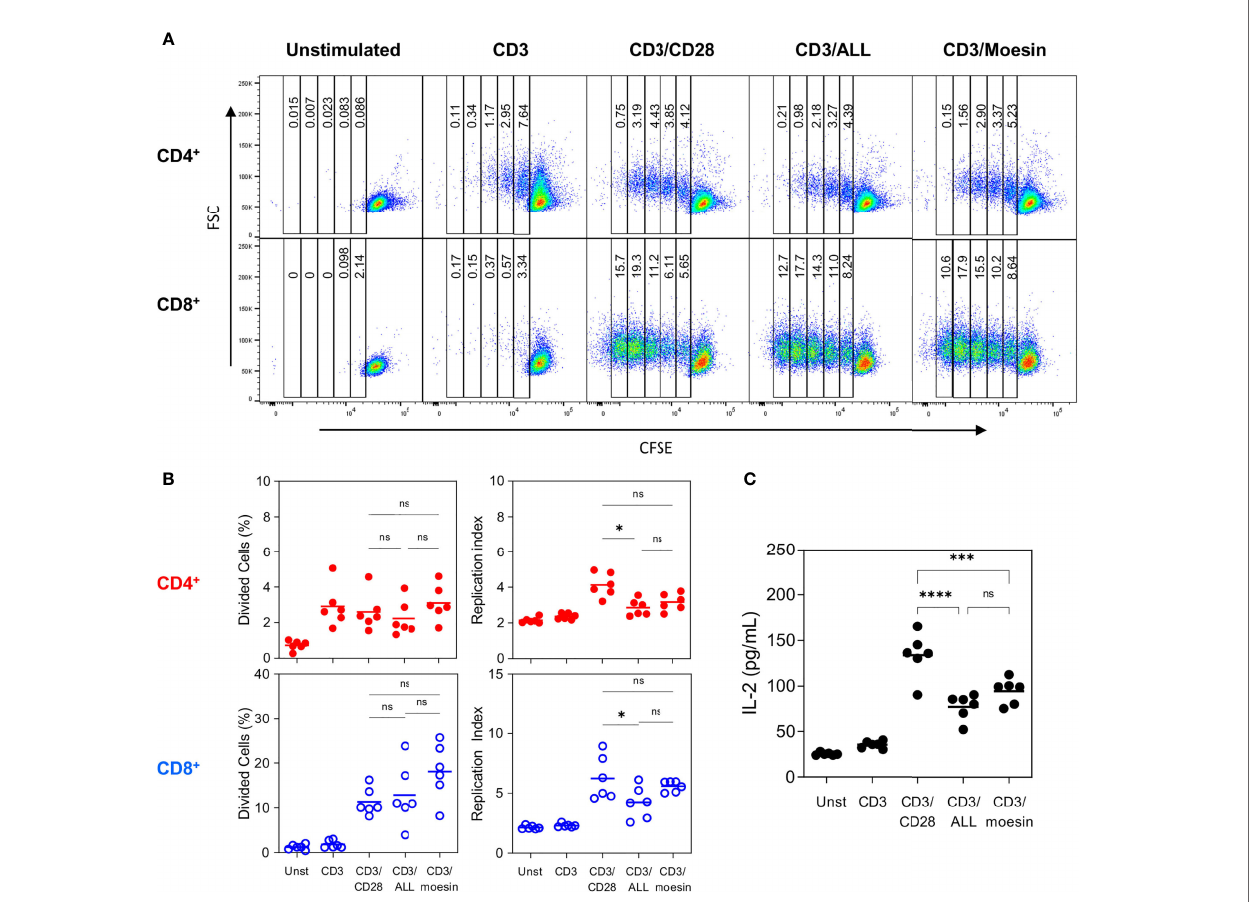
FIGURE 6 | Moesin costimulation induces proliferation in CD4 + and CD8 + T lymphocytes. Samples described in Figure 6 were further and identically analyzed within the CD4 - CD8 + and CD4 + CD8 + subsets to evaluate CFSE dilution. (A) Representative proliferation pattern analysis of CD4 + and CD8 + cells after activation with anti-CD3 and each costimulatory molecule. (B) Statistical analysis from 2 independent experiments with 3 mice per group expressed as the percentage of divided cells or as the replication index (Total Number of divided cells/The number of cells that went into division). (C) Negatively separated T cells were activated with anti-CD3 and anti-CD28, ALL, or anti-moesin. After 48 h, culture supernatants were collected and IL-2 concentration was determined by ELISA. Data correspond to 2 independent experiments with 3 mice per group and were analyzed using ANOVA and Bonferroni ’ s multiple comparison test. ns, not signi fi cant, *p < 0.05, ***p < 0.001, ****p < 0.0001. Additional controls performed in this experiment included cells stimulated with anti-CD28, ALL or anti-moesin only, anti- CD28/ALL, or anti-CD28/anti-moesin are shown in Supplementary Figure 4